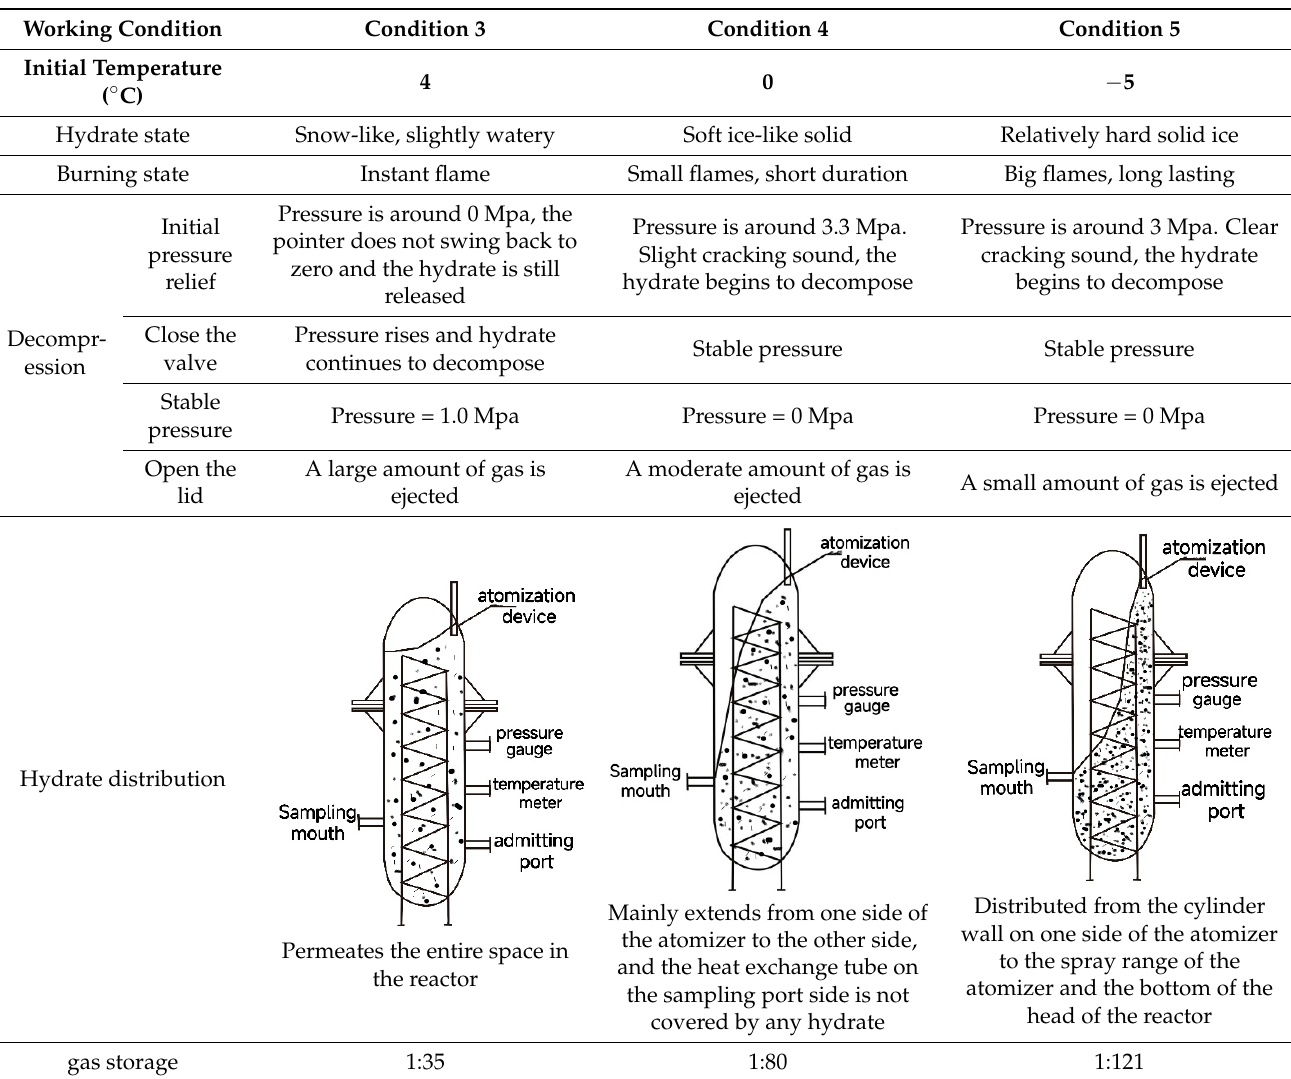
Table 6. Comparison for field observation.